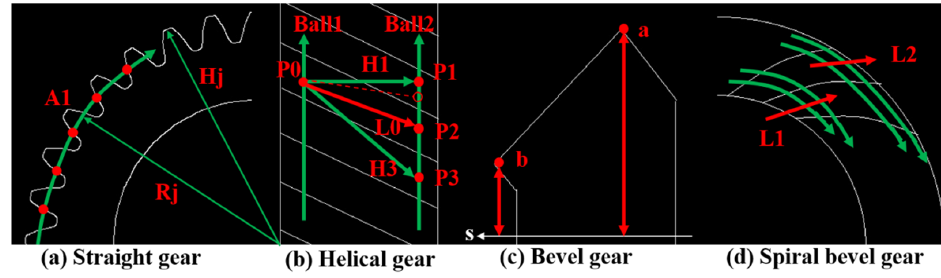
Figure 6. Gear feature parameter detection.